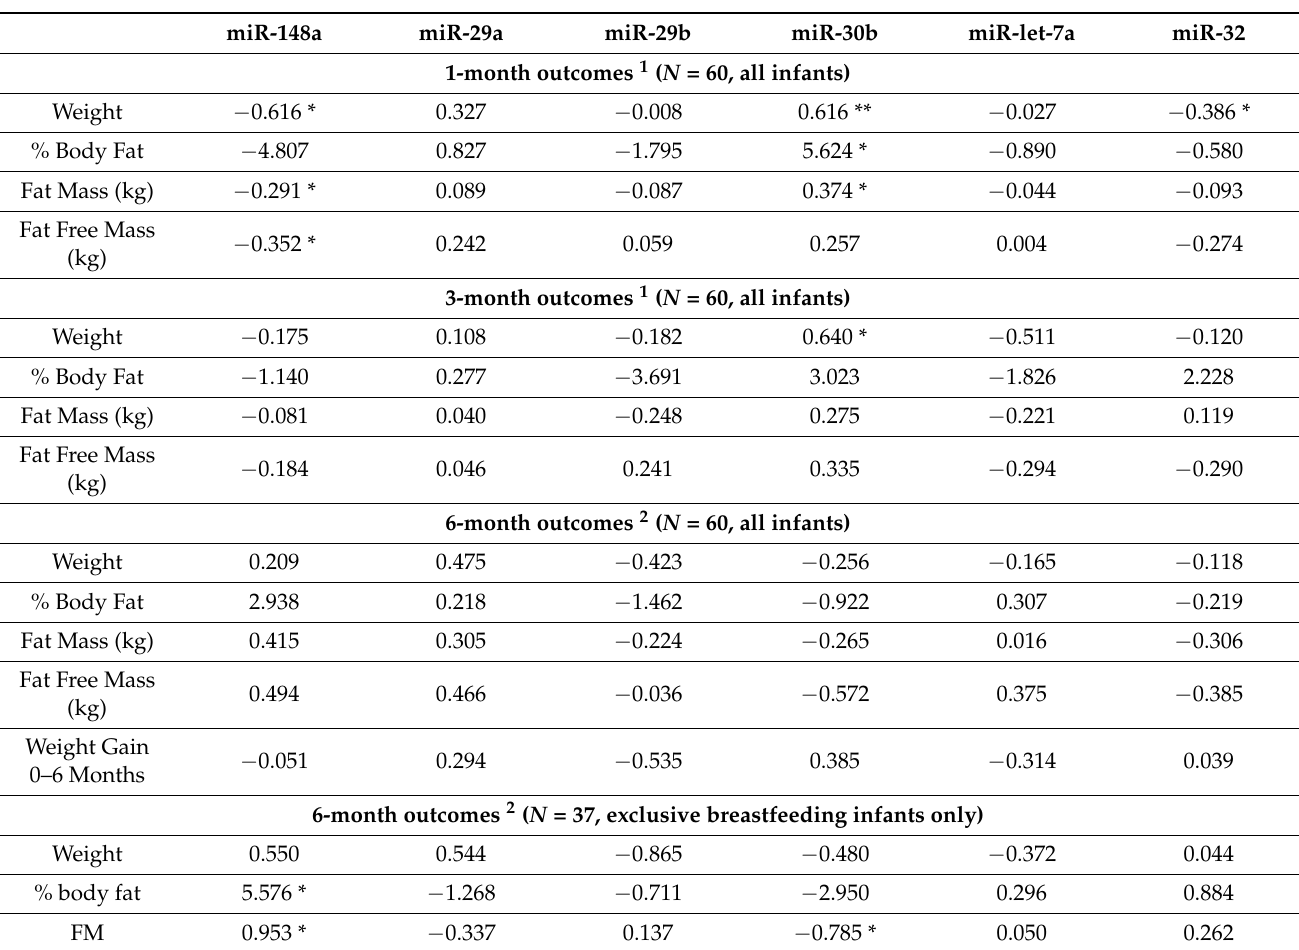
(a) MiRNAs sampled at 1-month were associated with infant anthropometrics at 1 month miR-148a and miR-30b were both significantly associated with infant weight and body composition measures at 1 month, even while controlling for infant gestational age, birth weight, and infant sex (Table 2). For every fold increase in miR-148a, 1-month infant weight, FM, and FFM decreased by 0.61 kg, 0.29 kg, and 0.35 kg, respectively. For every fold increase in miR-32, 1-month infant weight decreased by 0.39 kg. In contrast, the abundance of miR-30b was positively associated with infant anthropometrics. For every fold increase in miR-30b abundance, 1-month infant weight, % body fat, and FM increased by 0.61 kg, 5.62%, and 0.37 kg, respectively. Table 2. Associations between 1-month breast milk exosomal miRNA abundance and infant outcomes at 1, 3 and 6 months of